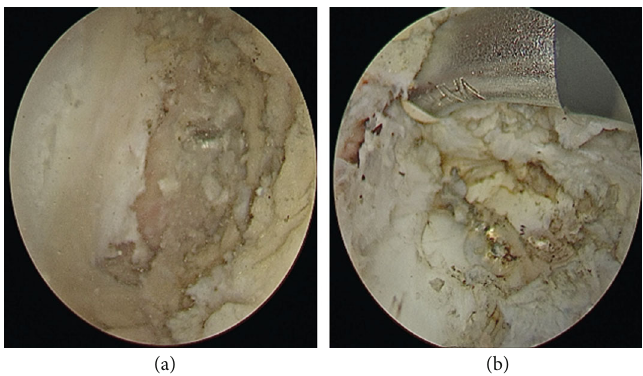
Figure 5: Arthroscopic photo for preparing for tunnels (a) femur drilled tunnel and (b) tibial drilled tunnel.